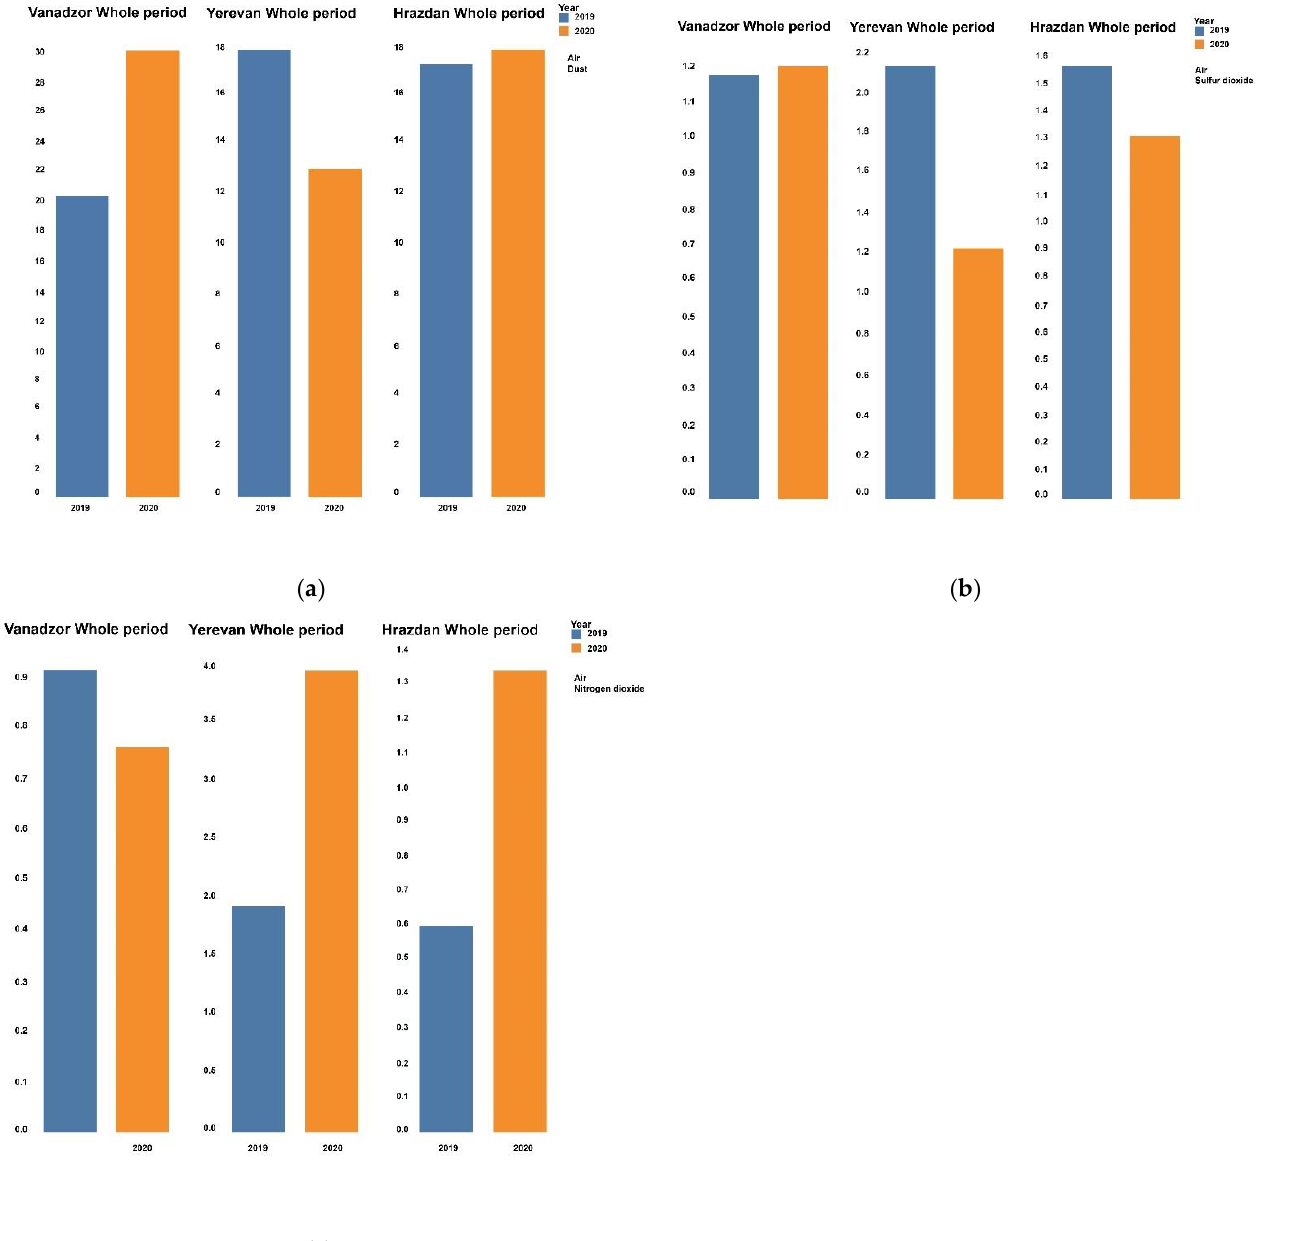
Figure 2. Cumulative concentrations of dust ( a ), sulfur dioxide ( b ) and nitrogen dioxide ( c ) in Yerevan, Vanadzor and Hrazdan during March–June in 2019 and